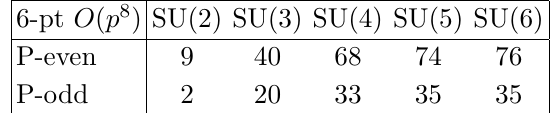
Table 11 . Number of independent 6-pt soft blocks at order O ( p 6 ) , with both parities and different finite N flavor symmetries. f